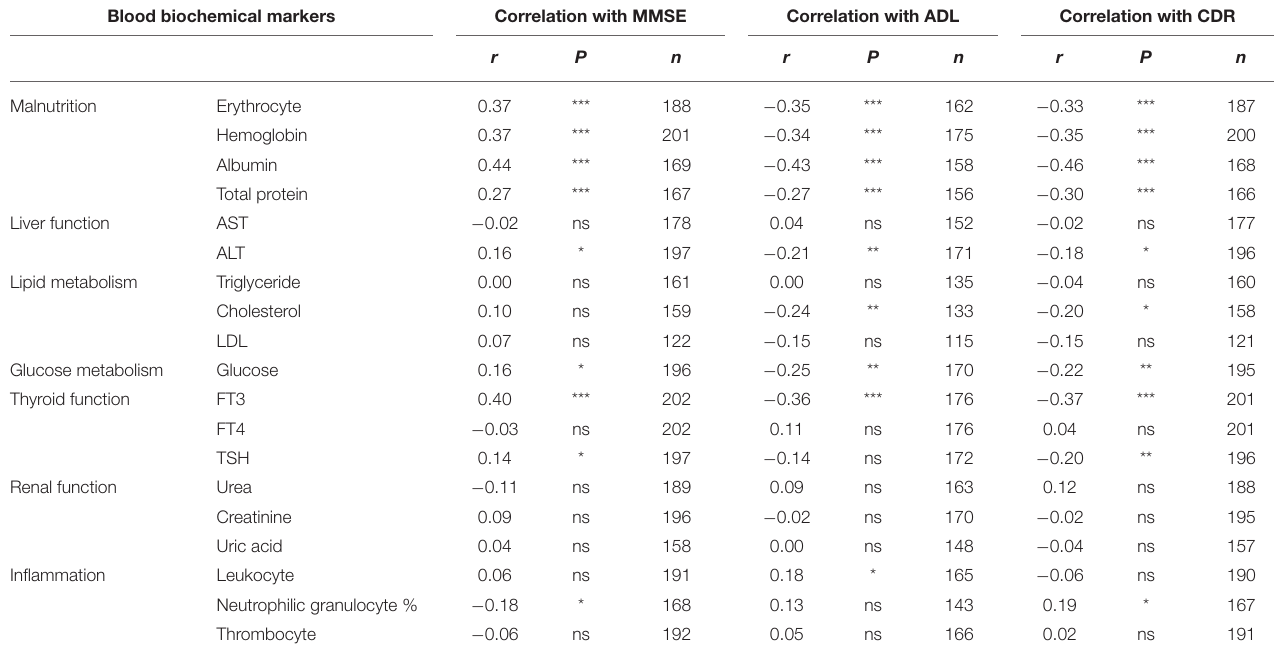
TABLE 2 | Association between biochemical indicators and cognitive dysfunction in AD patients. Blood biochemical markers